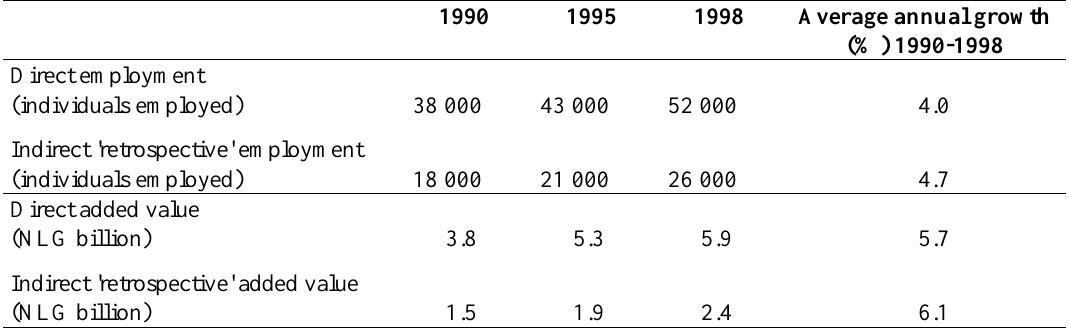
Table 4. Employment and added value at the mainport Amsterdam Schiphol, 1990-